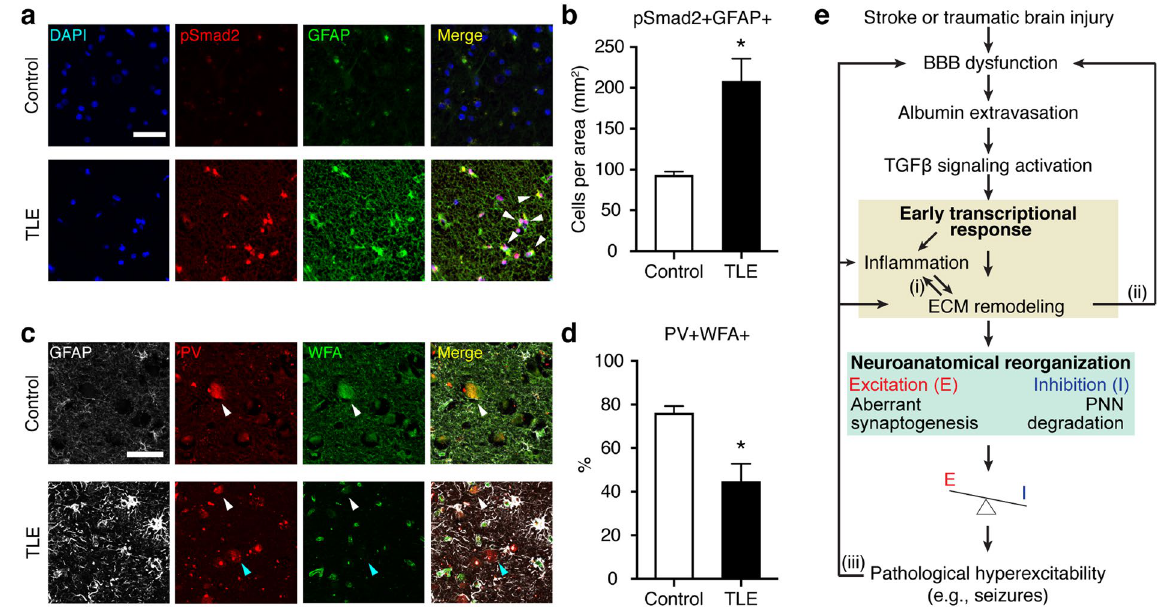
Figure 6. Increased expression of astrocytic pSmad2 and reduced association of PNNs around PV( + ) cells in human epileptic hippocampi. ( a ) Representative micrographs of human hippocampi stained for GFAP and phosphorylated Smad2, a downstream effecter of TGF β signaling. The hippocampi were resected from temporal lobe epilepsy (TLE) patients or age-matched autopsy controls. Representative GFAP( + ) astrocytes expressing pSmad2( + ) are indicated by white arrowheads. Scale bar = 50 μ m. ( b ) Co-localization of pSmad2 with GFAP was increased in TLE patients (n = 5) compared to controls (n = 3). ( c ) Representative confocal micrographs of human hippocampal tissues stained for GFAP, PV, and PNNs (WFA) resected from TLE patients or controls. Scale bar = 50 μ m. White and blue arrowheads indicate representative PV( + )/WFA( + ) and PV( + )/ WFA( − ) cells, respectively. ( d ) The percentage of PV( + )/WFA( + ) cells was decreased in the hippocampus of TLE patients (n = 4) compared to controls (n = 4). Mann-Whitney test, two-tailed, was used for statistical analyses. * p < 0.05. ( e ) A working model. Several points for feed-forward loops (i-iii) can lead to